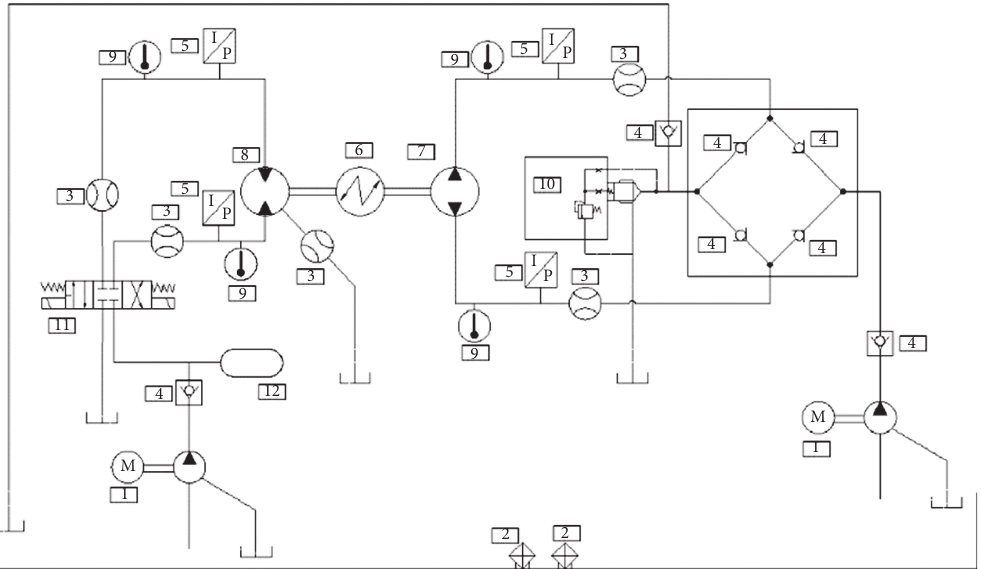
Figure 4: The principle of the hydraulic test rig.